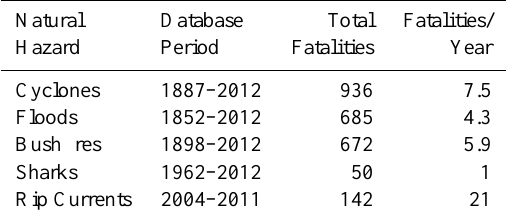
Table 1. Average number of fatalities per year attributed to different natural hazards in Australia based on the longest available datasets.